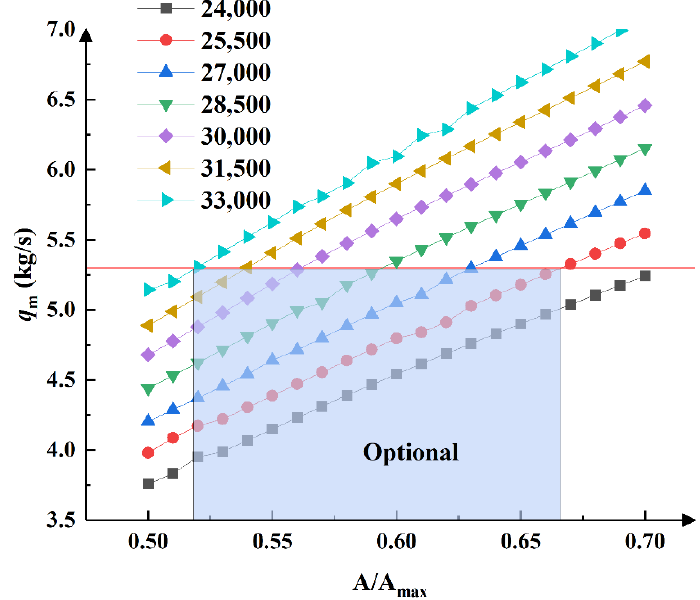
Figure 14. Mass flow vs. speed and valve opening under medium operating conditions.